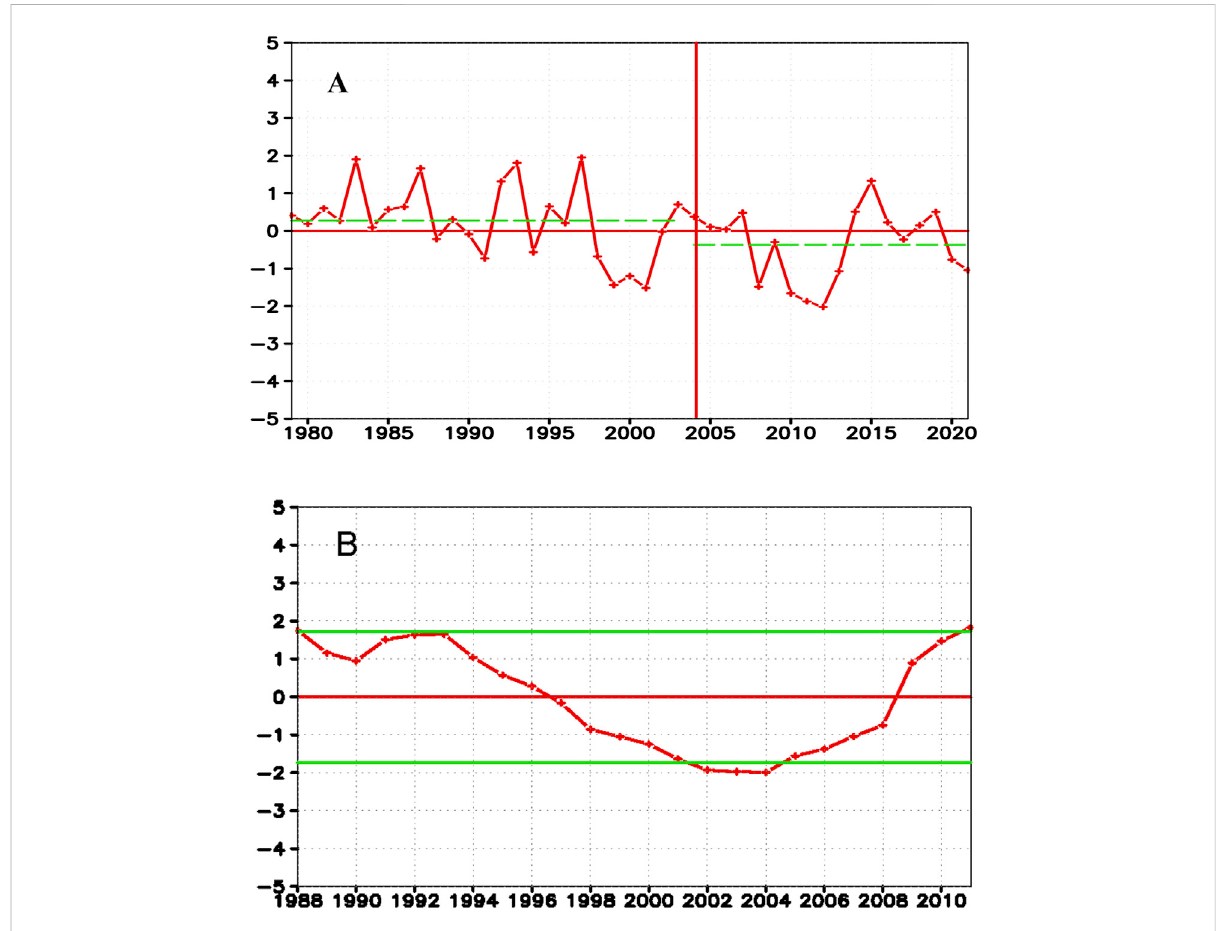
FIGURE 4 ThesameasFigure2,butfornormalizedtimeseriesofPDOindexinJuly – Augustduring1979 – 2021.Thehorizontaldashlinesin (A) indicatethe mean during two periods, and the vertical line indicates the interdecadal abruptchange year. Two green lines showing a 95% con fi dence level in the 20-year running t-test in (B) .